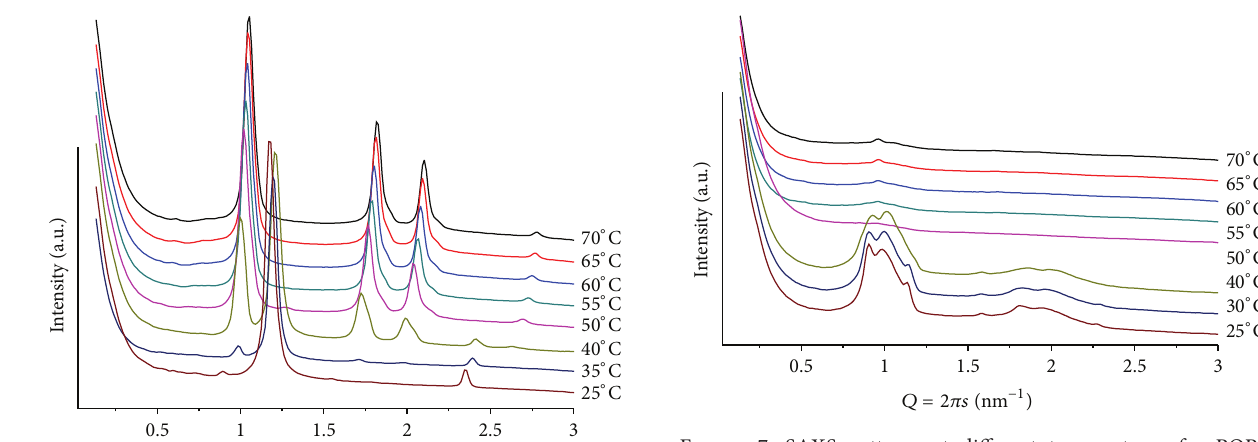
Figure 7: SAXS patterns at different temperatures for POPC/ ANHQ, mr = 50 and pH = 4